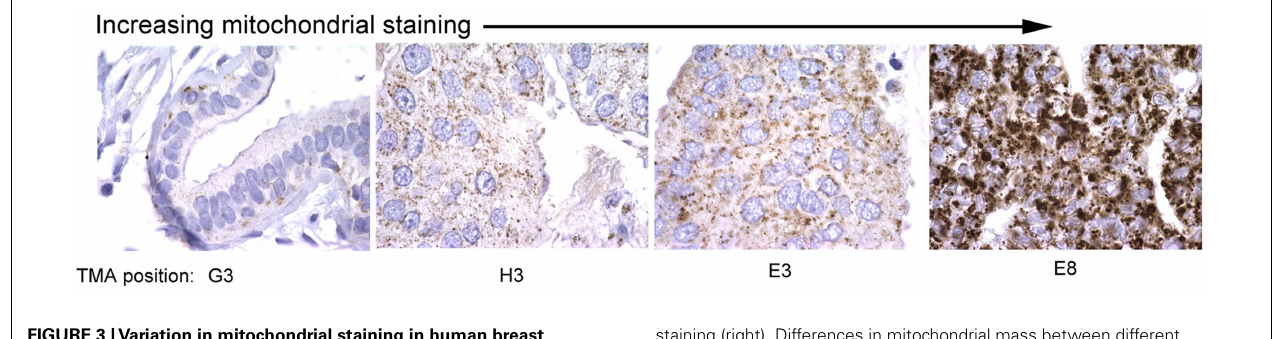
FIGURE 3 |Variation in mitochondrial staining in human breast cancers . Immunohistochemical staining for mitochondrial 60kDa antigen (Biogenex clone 113-1) reveals marked variations in mitochondrial staining between different primary human breast cancers with some tumors showing very low staining (left) and others very high